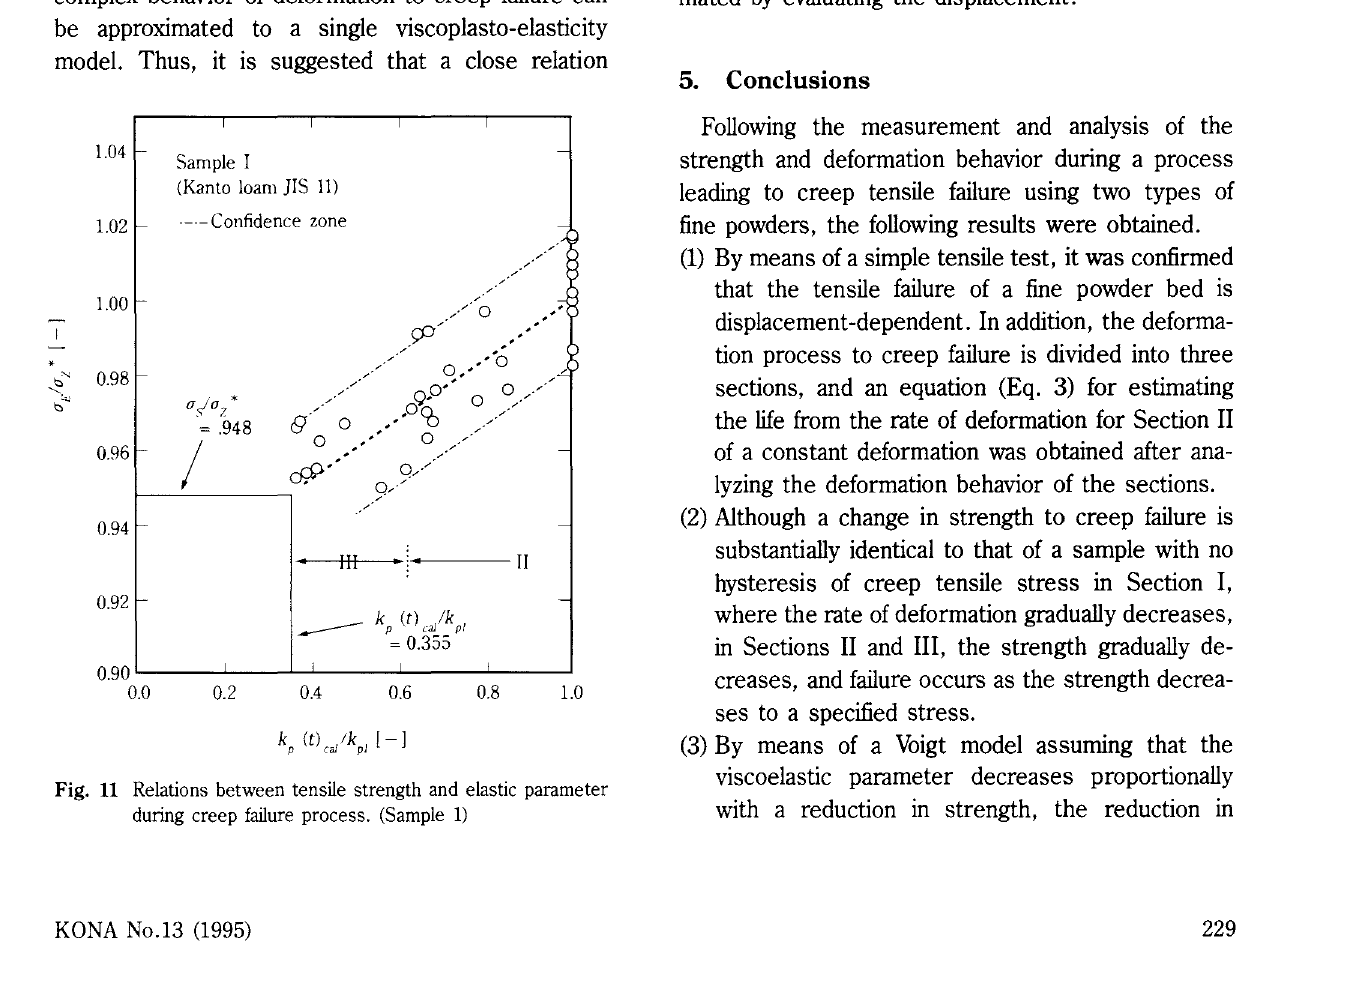
Fig. 12 Relations between tensile strength and elastic parameter during creep failure process. (Sample